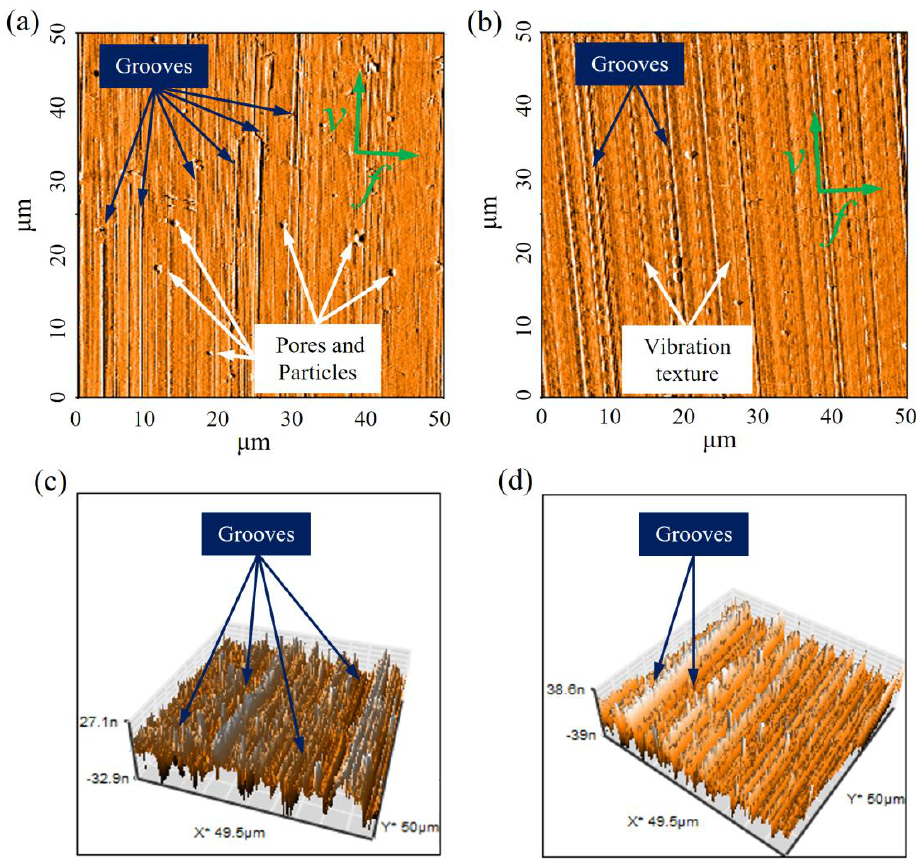
Figure 6. The AFM images of measurement area Ⅱ : ( a ) two-dimensional machined surface under CC process; ( b ) two-dimensional machined surface under UEVC process; ( c ) three-dimensional machined surface under CC process; ( d ) three-dimensional machined surface under UEVC process.